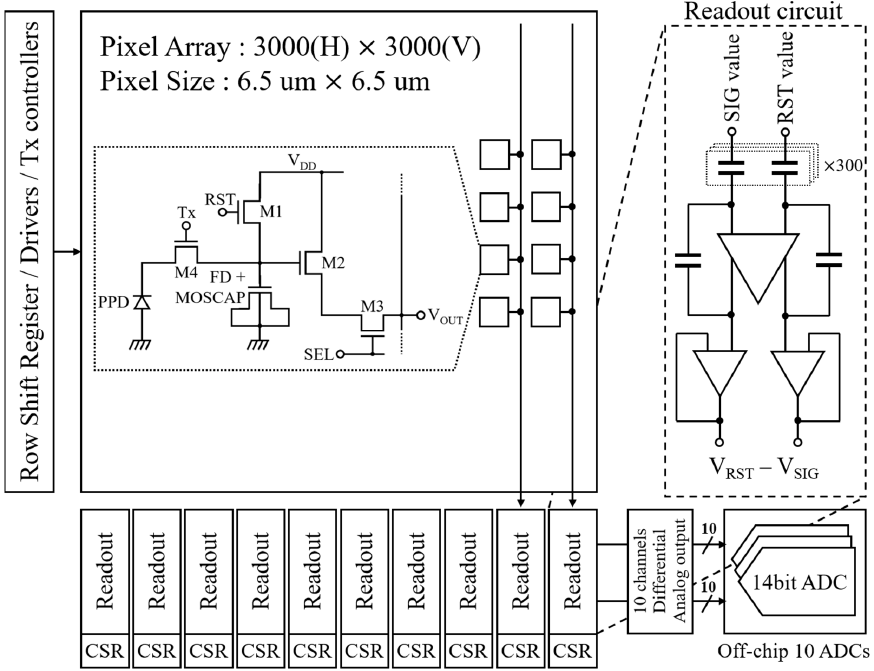
Figure 1. CMOS image sensor (CIS) block diagram. CSR, column shift register; ADCs, analog to digital converters.